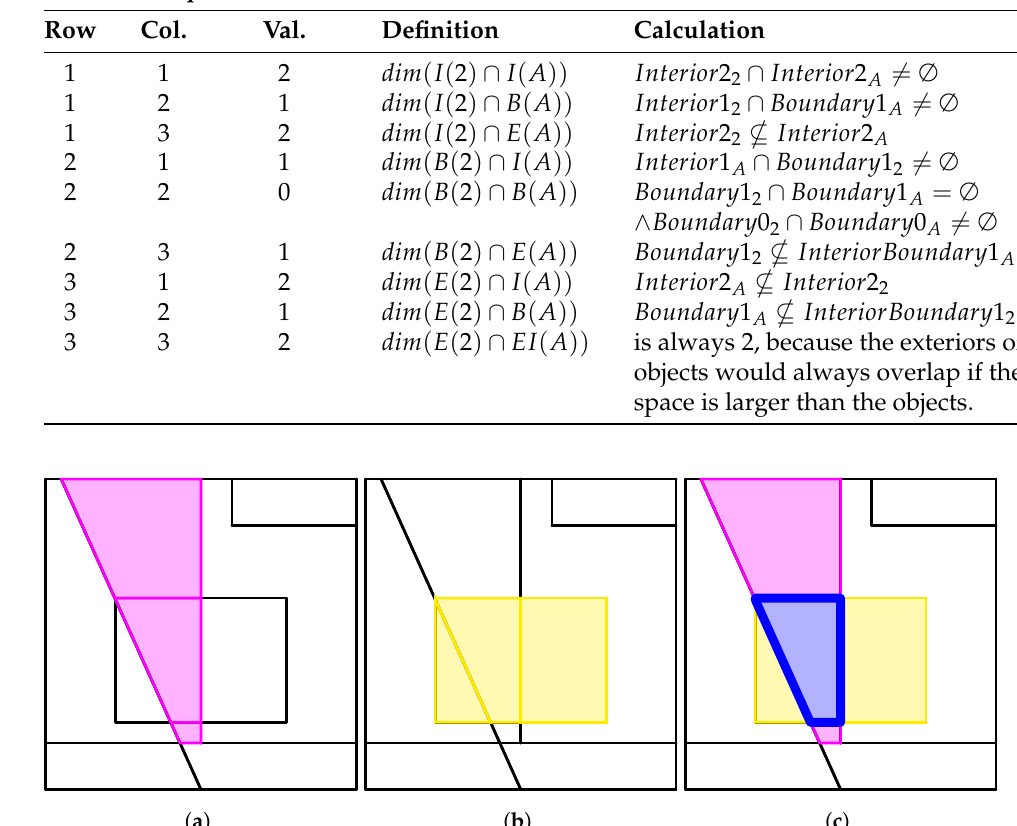
Figure 10. Intersection as set operation. ( a ) Parts of feature 2. ( b ) Parts of feature A. ( c ) Common